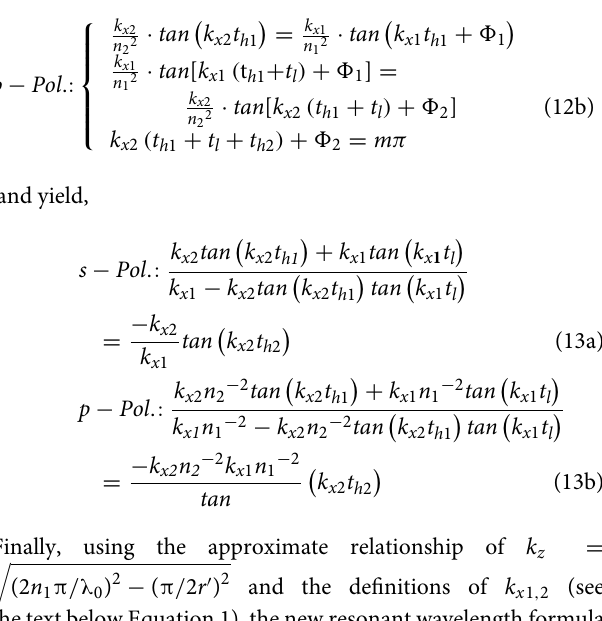
FIGURE 9 | Semi-analytically modeled attenuations of (A) a single-wall square ARF (the black lines) against its hypocycloidal variant (the red lines) and (B) a H/L/H square fiber (the blue lines) against its hypocycloidal counterpart (the magenta lines). a 0.67 µ m, and t l 1.5 µ m. The agreement of modeling and simulation =